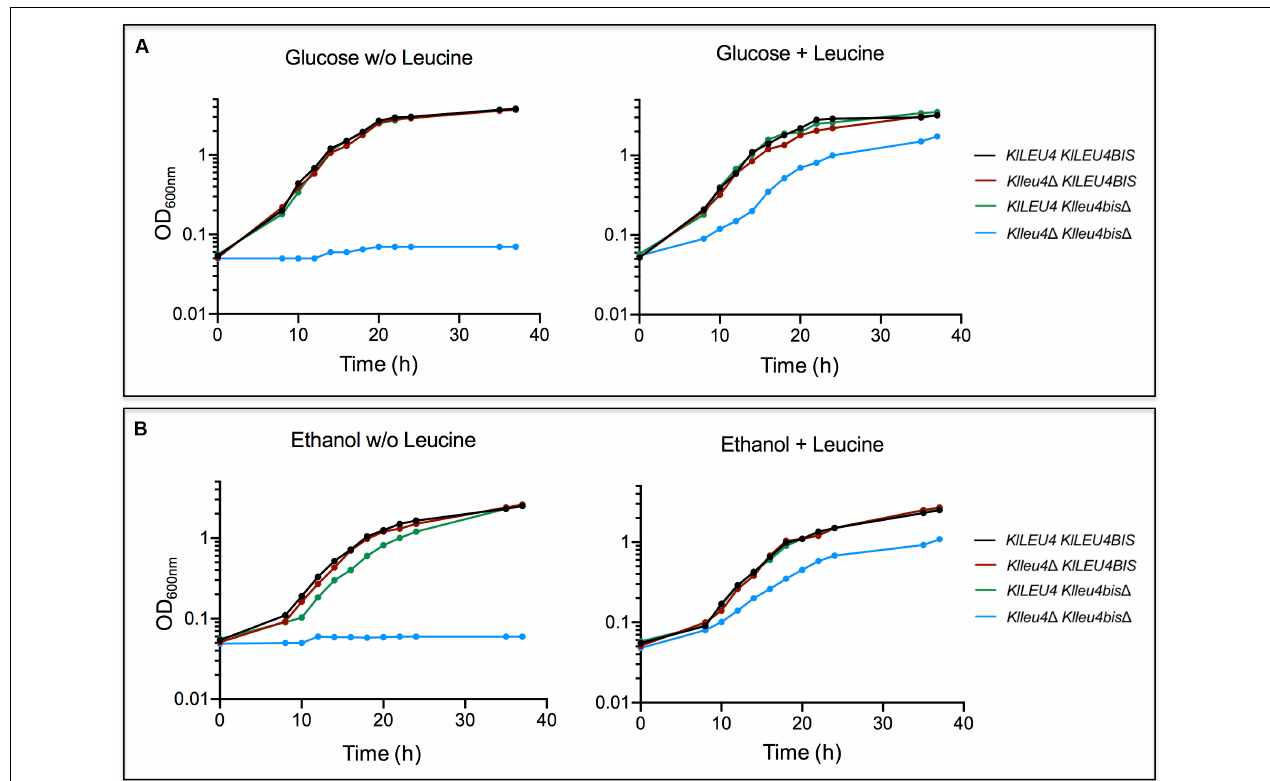
FIGURE 2 | K. lactis growth curves of derived single and double KlLEU4 and KlLEU4BIS mutants. Strains were grown on minimal medium with 2% w/v glucose (A) or 2% v/v ethanol (B) as carbon sources, with or w/o leucine (0.1 mg/mL). Growth curves of wild type KlLEU4 KlLEU4BIS strain are shown as growth controls. Experiments were done in